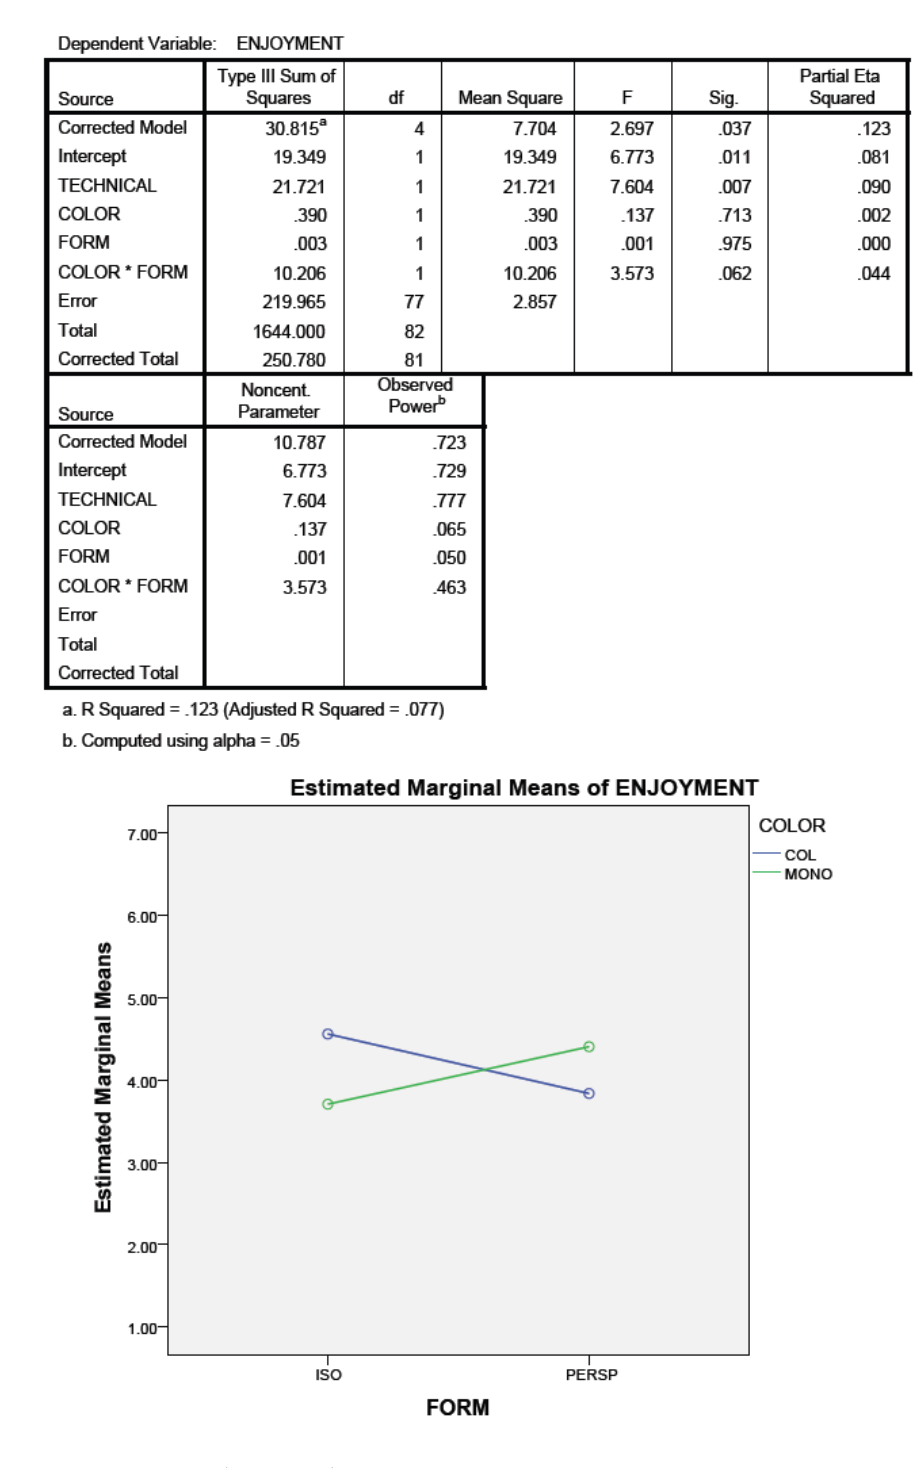
Figure B.18. ANCOVA analysing enjoyment levels for the main and interaction effects of color and form using data adjusted for technical